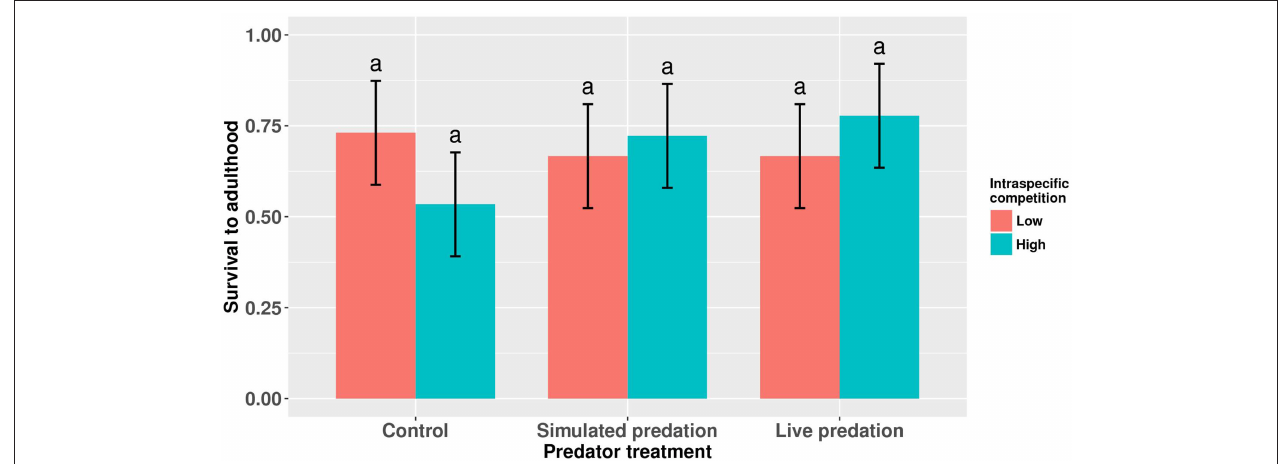
FIGURE 1 | Proportion survivorship to eclosion of female Aedes aegypti larvae exposed to intraspecific competition and predator treatments. Values plotted are least squares means ± 95% confidence intervals (CI). Data were statistically tested using ANOVA and significant effects are described in Table 1 . Treatment means associated with the same letters are not significantly different in pairwise comparisons using Bonferroni adjustment for multiple tests.